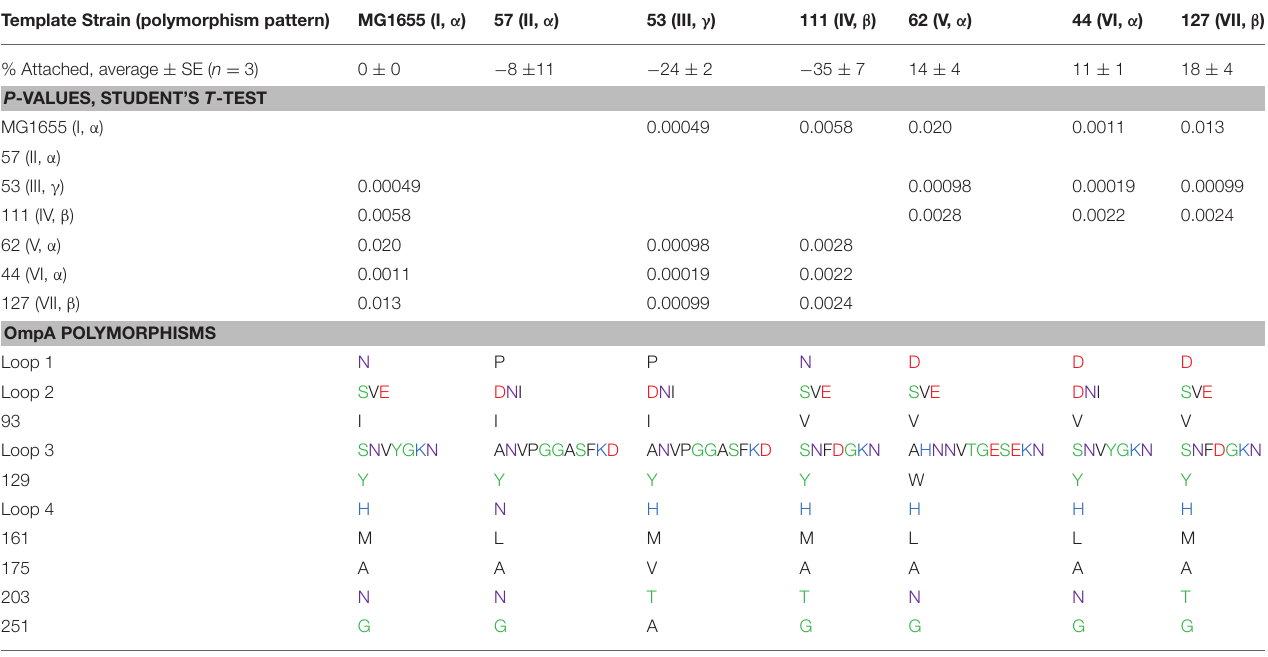
TABLE 5 | Expression of distinct OmpA variants in the same genetic background significantly impacts attachment to corn stover. Template Strain (polymorphism